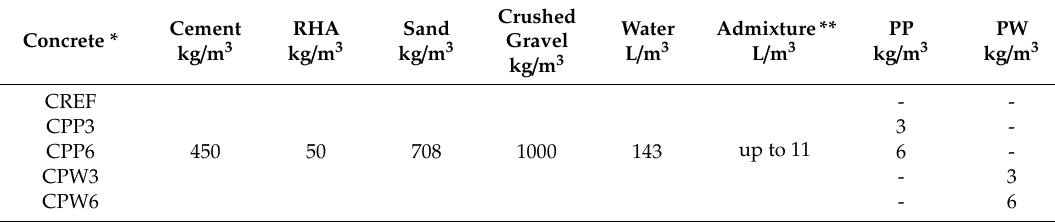
Table 1. Concrete mix proportion.